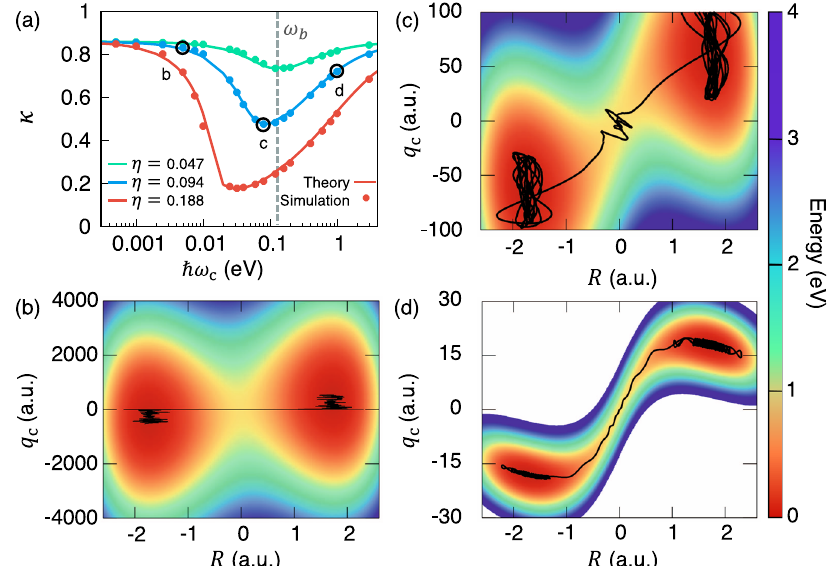
Fig. 3 Resonant effect in vibrational strong coupling regime of polariton chemistry. a Transmission coef fi cient κ as a function of the photon frequency at three different values of the coupling strength η . b – d The cavity Born – Oppenheimer surfaces V CBO ( q c , R ) under the normalized coupling strength η = 0.094 (corresponding to the blue solid line in panel ( a )) at the photon frequency b ℏ ω c = 2.5 meV, c 80 meV, and d 1.0 eV, with the representative reactive trajectories indicated with black solid